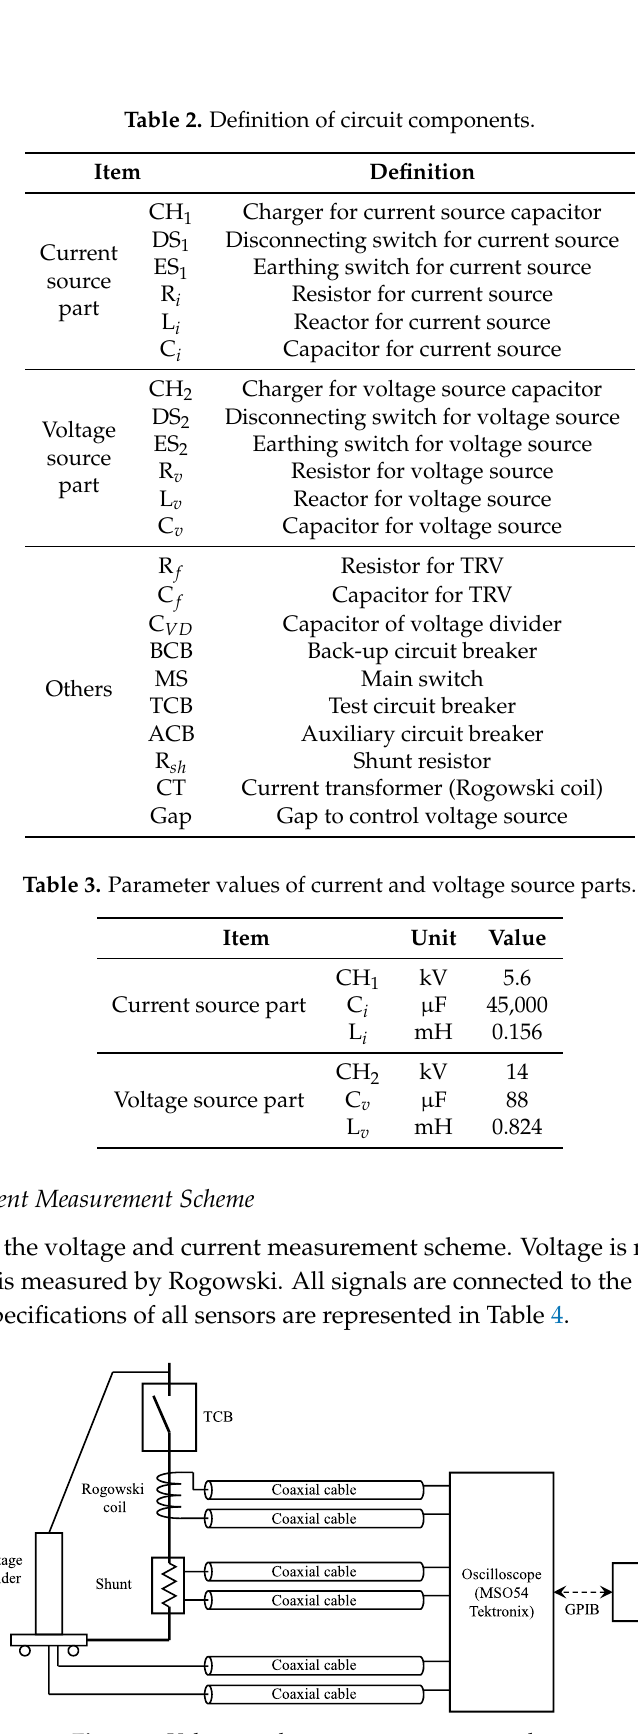
Figure 2. Voltage and current measurement